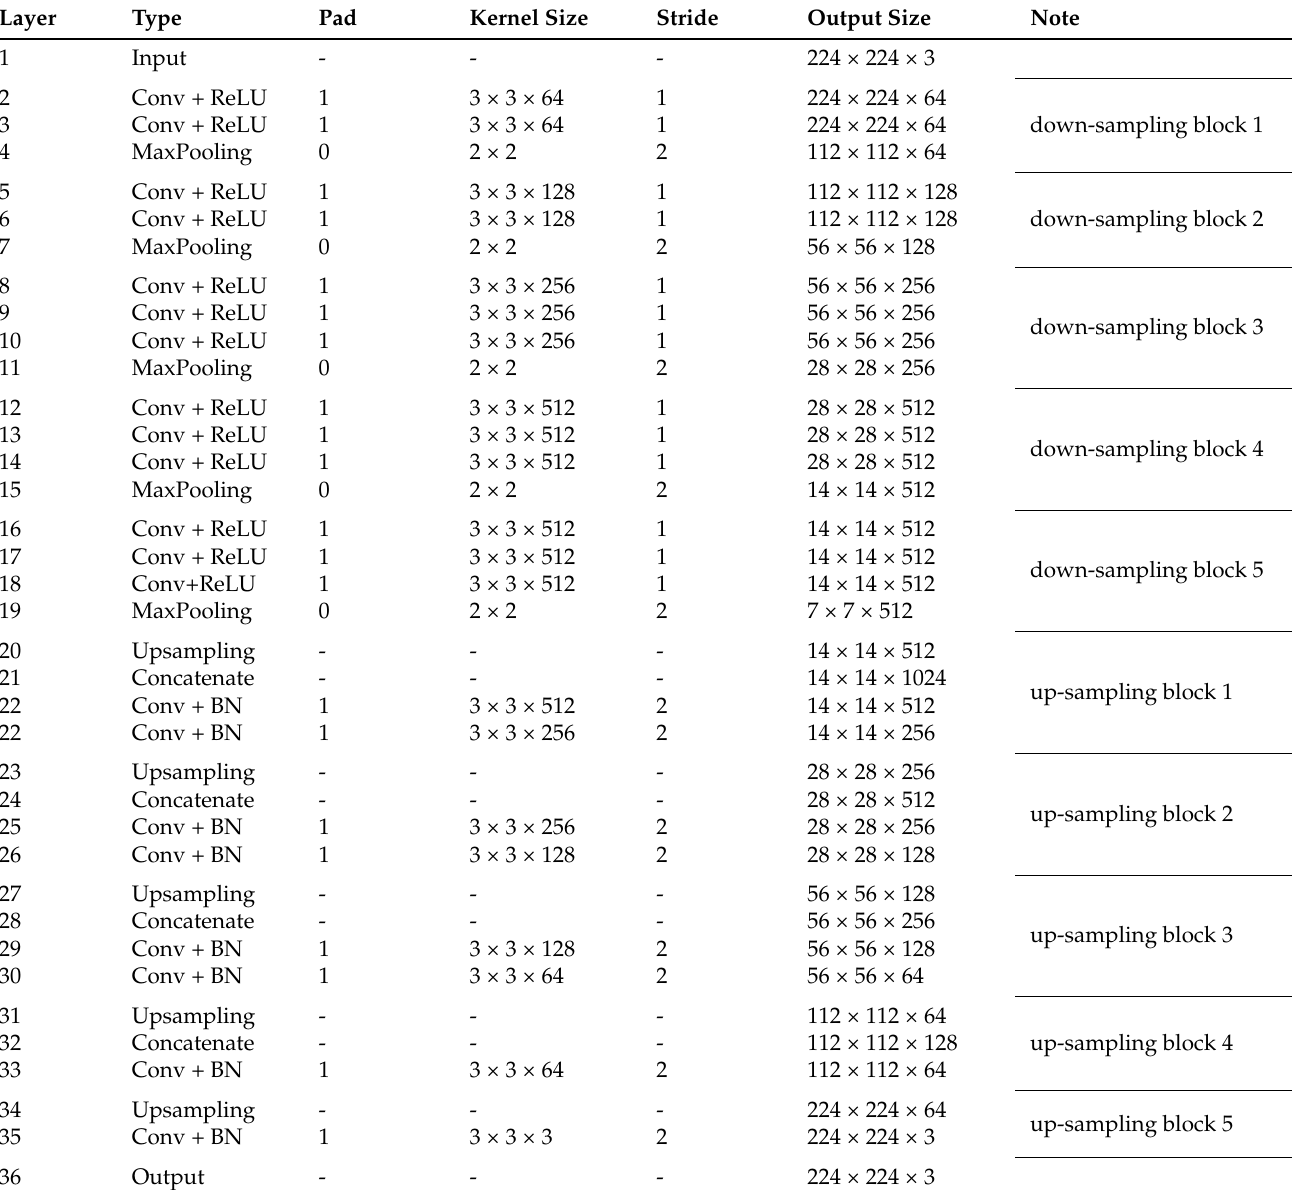
Table 1. The detailed configuration and specifications of